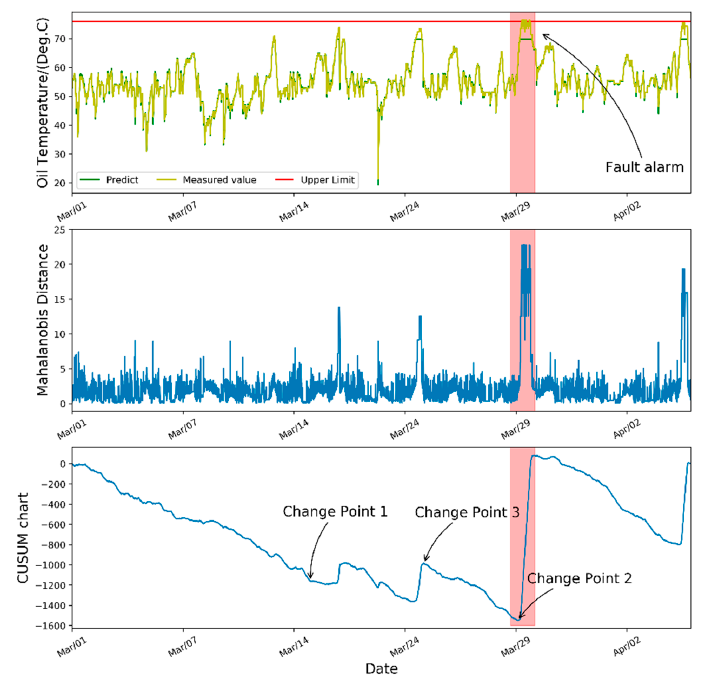
Figure 10. Testing the fault prediction approach results for Turbine #38.